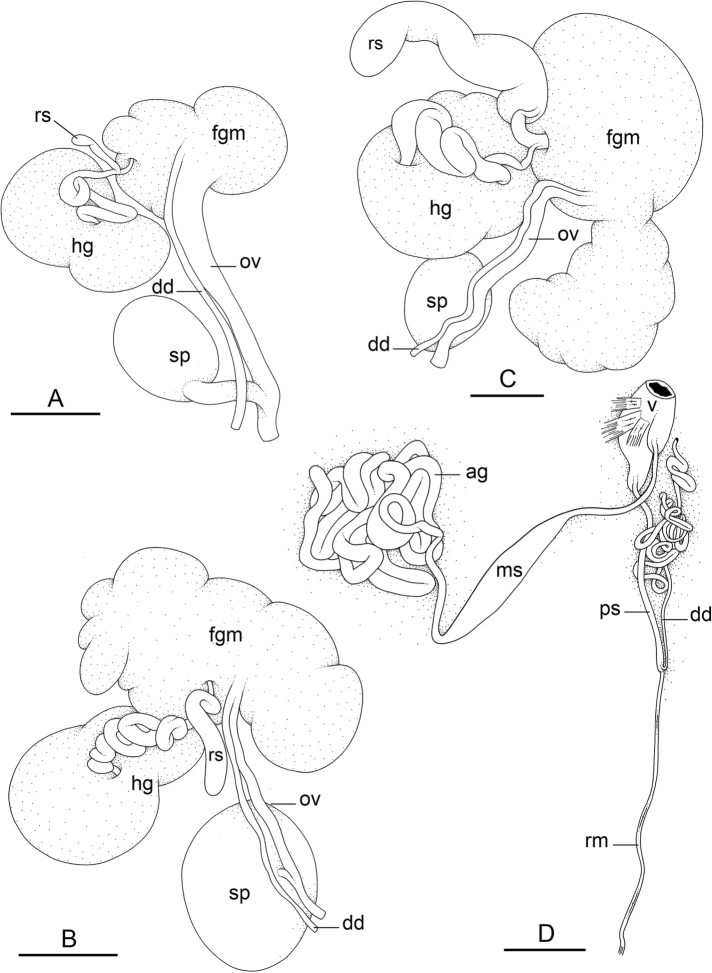
Reproductive system, Peronia
verruculata (unit #1) A immature, posterior, hermaphroditic (female) reproductive system, Australia, Queensland [2622] (MTQ) B posterior, hermaphroditic (female) reproductive system, Vietnam [5621] (ITBZC IM 00021) C posterior, hermaphroditic (female) reproductive system, Indonesia, Sulawesi [2127] (UMIZ 00170) D anterior, male, copulatory apparatus, same as C. Scale bars: 1 mm (A), 4 mm (B), 3 mm (C), 5 mm (D). Abbreviations: ag accessory penial gland, dd deferent duct, ddg dorsal digestive gland, fgm female gland mass, hg hermaphroditic gland, i intestine, ms muscular sac, ov oviduct, pdg posterior digestive gland, ps penial sheath, rm retractor muscle, rs receptaculum seminis, sp spermatheca, st stomach, v vestibule.